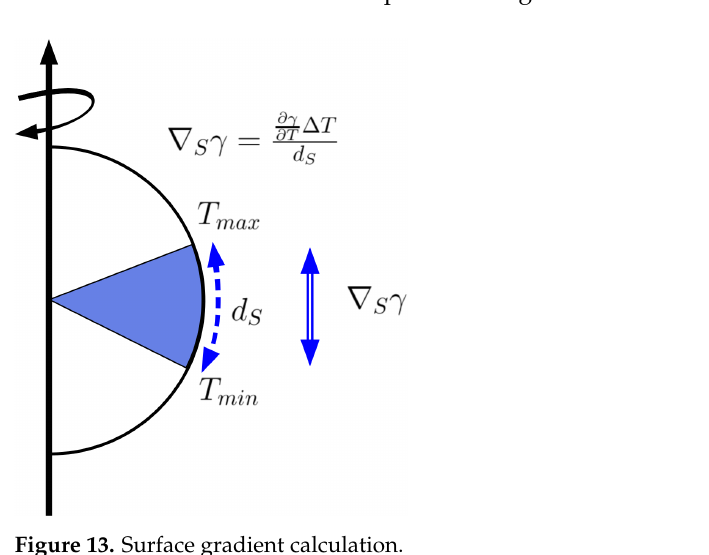
Figure 13. Surface gradient calculation.